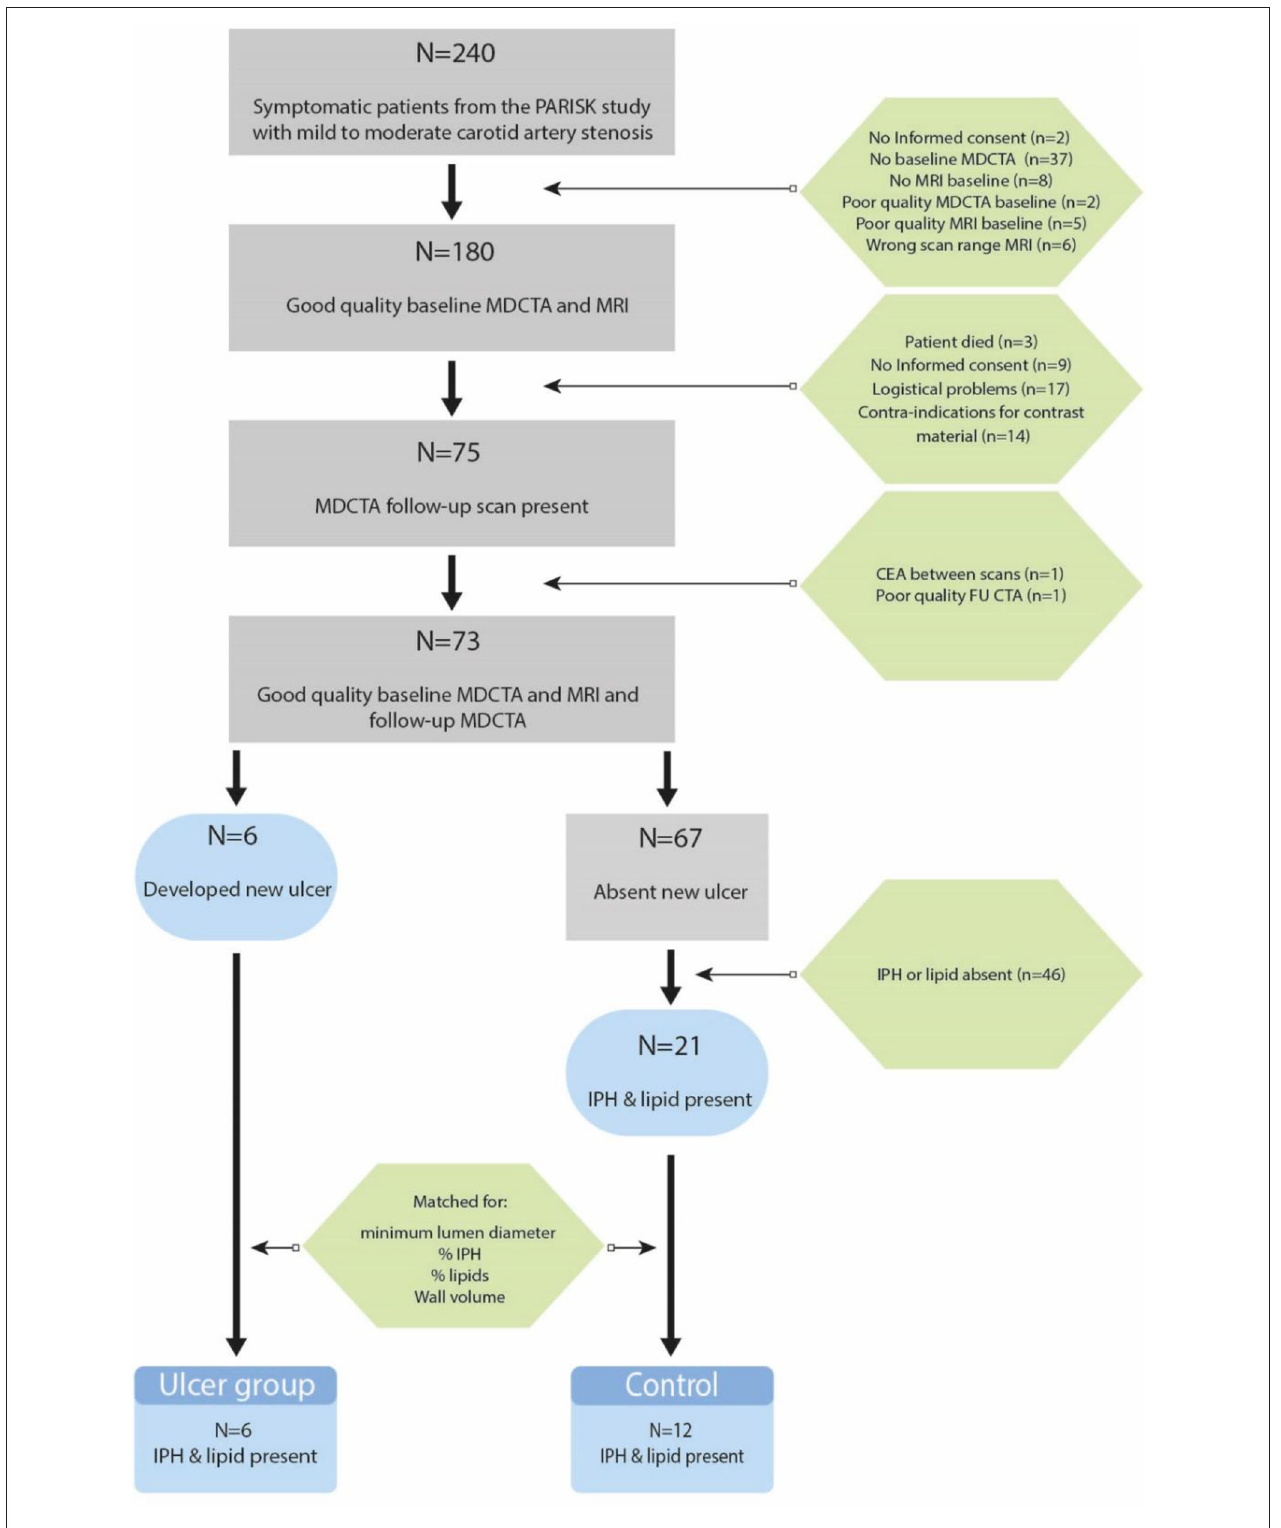
FIGURE 2 | Flow diagram of patients that are included and reasons for exclusion in the final data analysis.